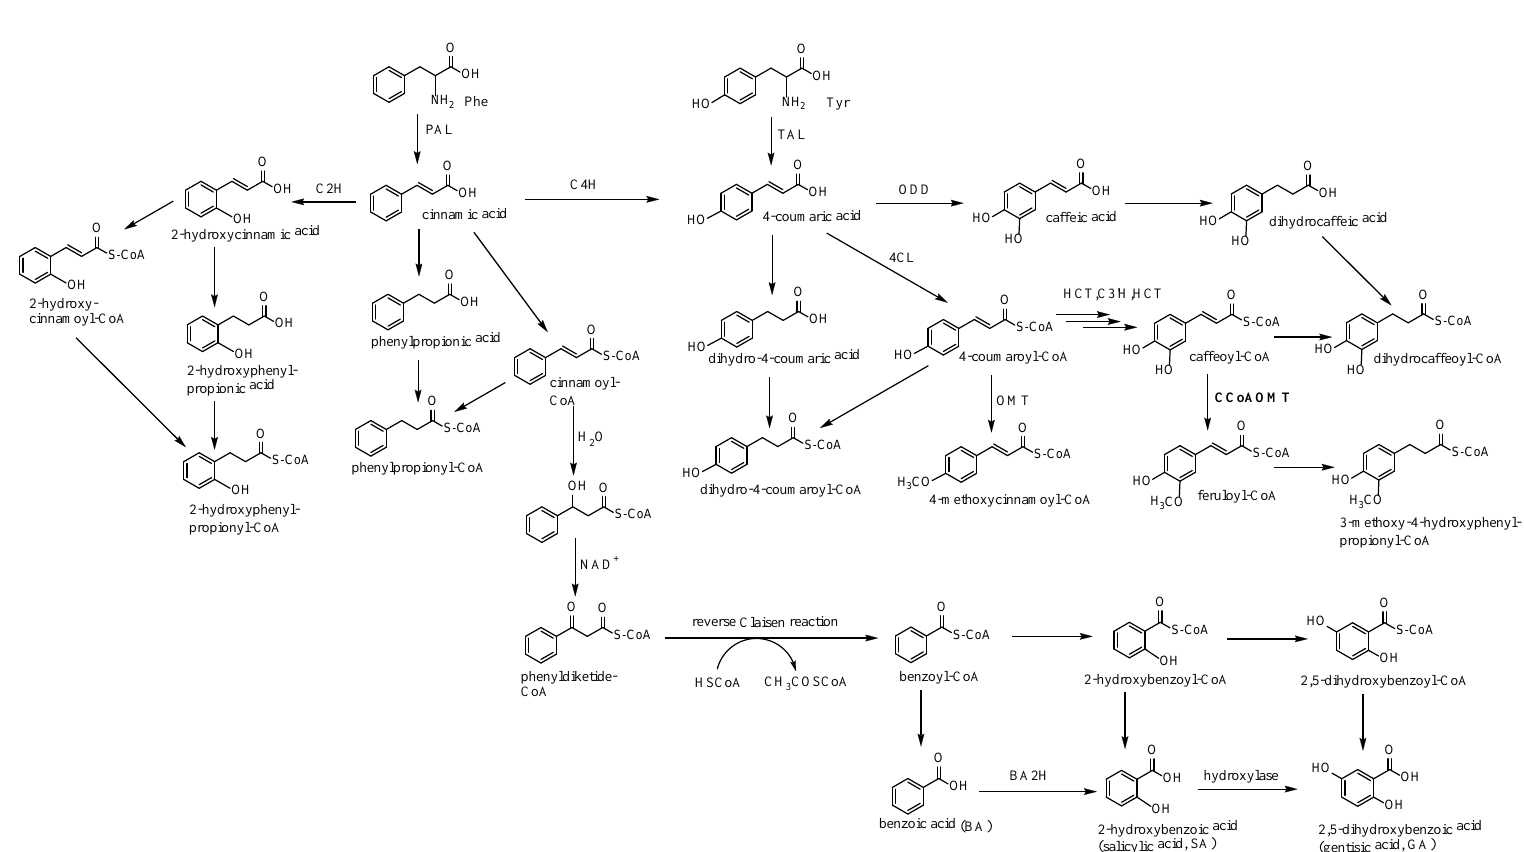
Figure 7. Plant phenolics based on phenylpropanoid pathway and their production as substrates for biosynthesis of polyketide class. PAL, phenylalanine ammonia lyase (MIO); TAL, tyrosine ammonia lyase; C4H, cinnamate-4-hydroxylase (O 2 , cytochrome P450, NADPH); C2H, cinnamate-2-hydroxylase (O 2 , cytochrome P450, NADPH); 4CL, 4-hydroxycinnamoyl-CoA ligase (ATP, coenzyme A [CoASH]); HCT, hydroxycinnamoyl-CoA:shikimate hydroxycinnamoyl transferase (shikimate); C3 ′ H, p -coumaroyl-5- O -shikimate 3 ′ -hydroxylase (O 2 , cytochrome P450, NADPH); CCoAOMT, caffeoyl-CoA O -methyl transferase (AdoMet); ODD, 2-oxoglutarate- dependent dioxygenase (α -ketoglutarate, Fe(II), ascorbate), BA2H, benzoic acid-2-hydroxylase .